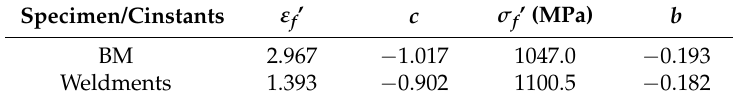
Table 3. The Coffin–Manson–Basquin (CMB) constants for Alloy 800H BM and weldments.